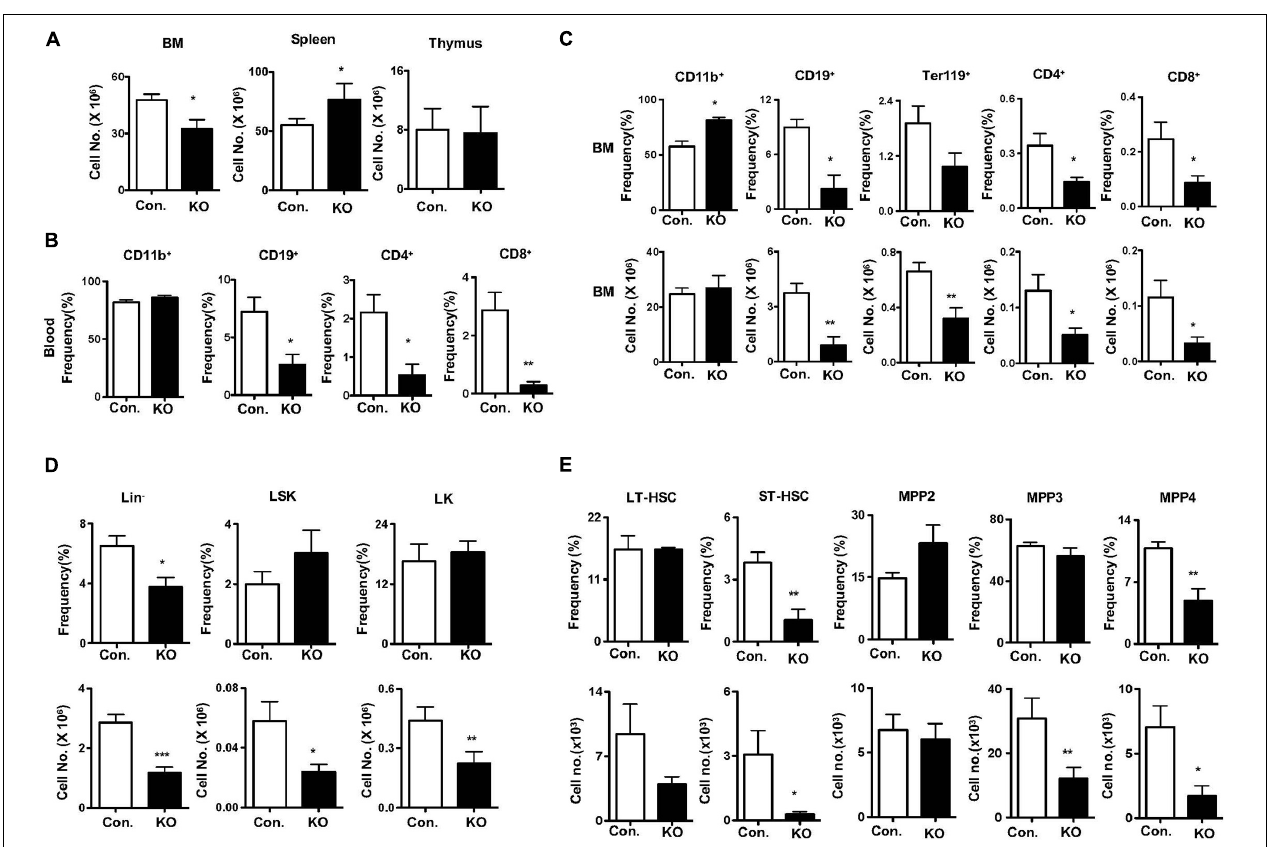
FIGURE 4 | Rbpj deficiency causes defective five-Fluorouracil and cytokine induced HSC response. (A) Total cell counts of BM, spleen and thymus from KO and control mice after 14 days of five-FU injection ( n = 5–7). (B) Frequencies of CD11b + , CD19 + , CD4 + , and CD8 + cells in the peripheral blood of KO and control mice after 14 days of five-FU injection ( n = 5–7). (C) Frequencies (top) and absolute numbers (bottom) of CD11b + , CD19 + , Ter119, CD4 + , and CD8 + cells in the BM of KO and control mice after 14 days of five-FU injection ( n = 5–7). (D,E) Frequencies (top) and absolute numbers (bottom) of Lin − , LK, LSK, LT-HSCs, ST-HSCs, MPP2, MPP3, and MPP4 subsets of BM from KO and control mice after 14 days of five-FU injection ( n = 5–7). All data represent mean ± SEM. Two-tailed Student’s t- tests were used to assess statistical significance (* P < 0.05; ** P < 0.01; *** P < 0.001).